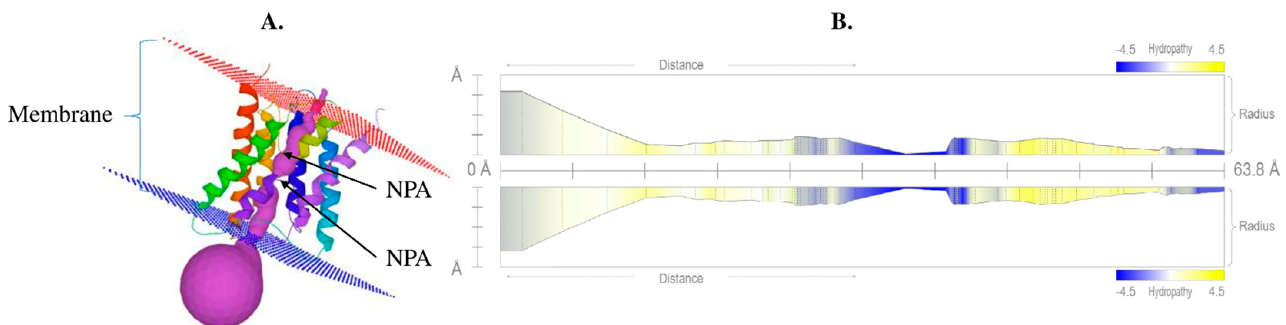
Figure 4. ( A ) Protein tertiary structure of silicon influx transporter VaNIP2-1 in Vigna angularis that clearly shows the presence of six transmembrane domains with NPA motifs; ( B ) hydropathy profile of pore with its radius. All the different colors in part ( A ) represent 6 different helices, and violet color represents pores. The yellow color represents the presence of hydrophobic residues whereas blue represents hydrophilic residues in ( B ).